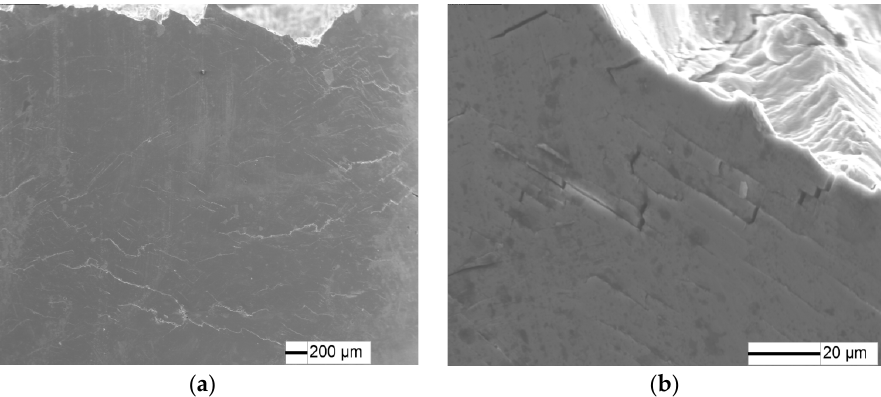
Figure 12. The morphology of the side crack at the crack initiation site at Δ ε t = 2.0%, N f = 1302 cycles.